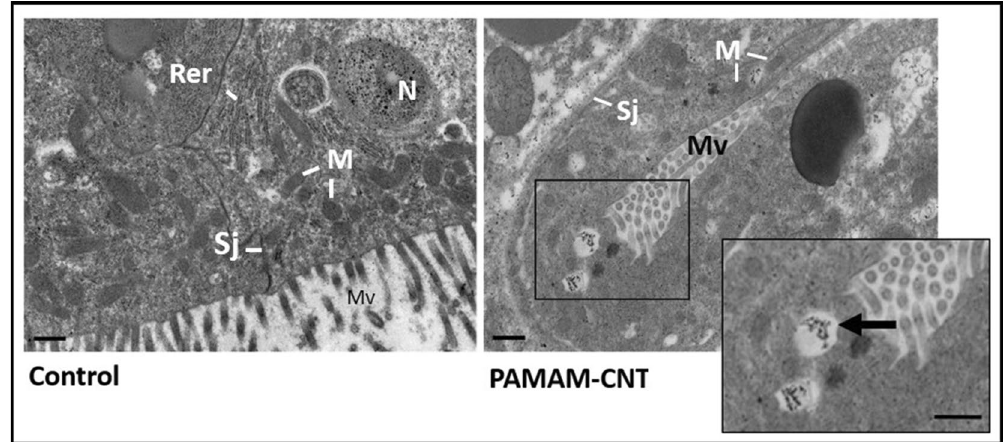
Figure 3. Transmission electron microscope images of sections of saline (control) and PAMAM-CNT- dsRNA αtub exposed T. castaneum larvae. Representative sections proximal to midgut tissue are shown. Arrows highlight intracellular vesicles containing PAMAM-CNT aggregates. Labels are rough endoplasmic reticulum (Rer), septate junction (Sj), mitochondria (M), microvilli (Mv) and nucleus (N) Scale = 2